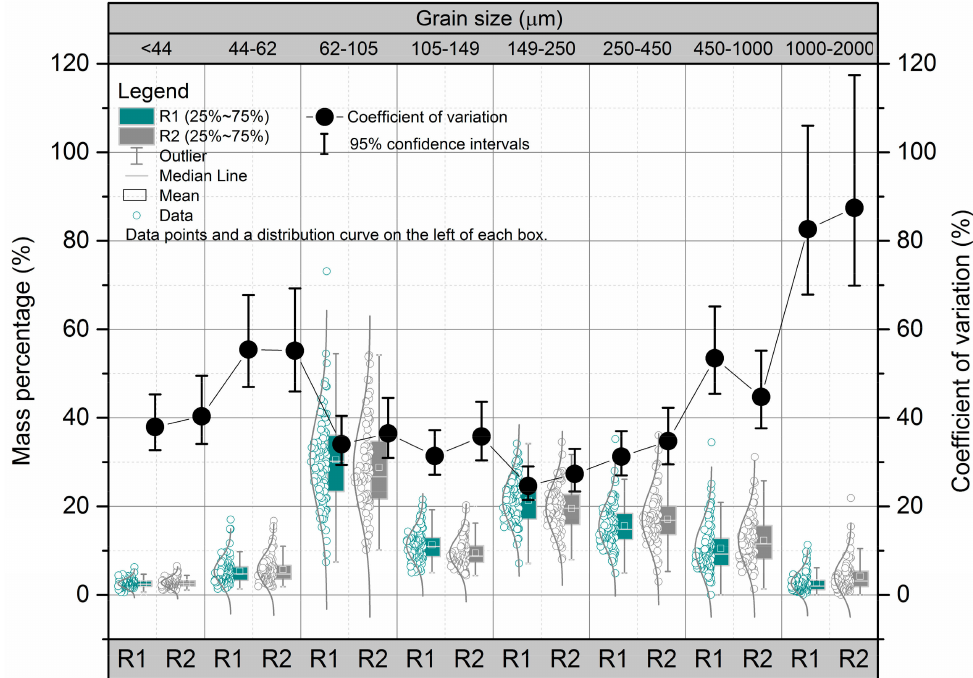
Figure 1. Grain-size heterogeneity in terms of the amounts present. Each Cv value shown is the mean ± the 95% confidence interval. R1 = areas in which there are main roads, R2 = residential